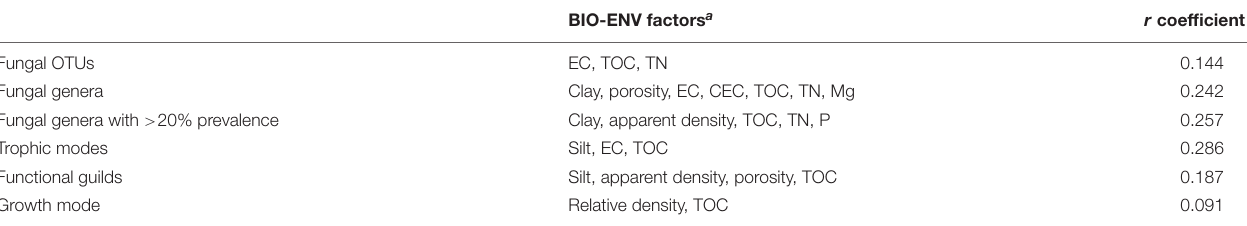
TABLE 1 | BIO-ENV Spearman rank coefficients ( r ) of correlations between soil fungal operational taxonomic units (OTUs), genus, ecological guilds, and edaphic soil properties.